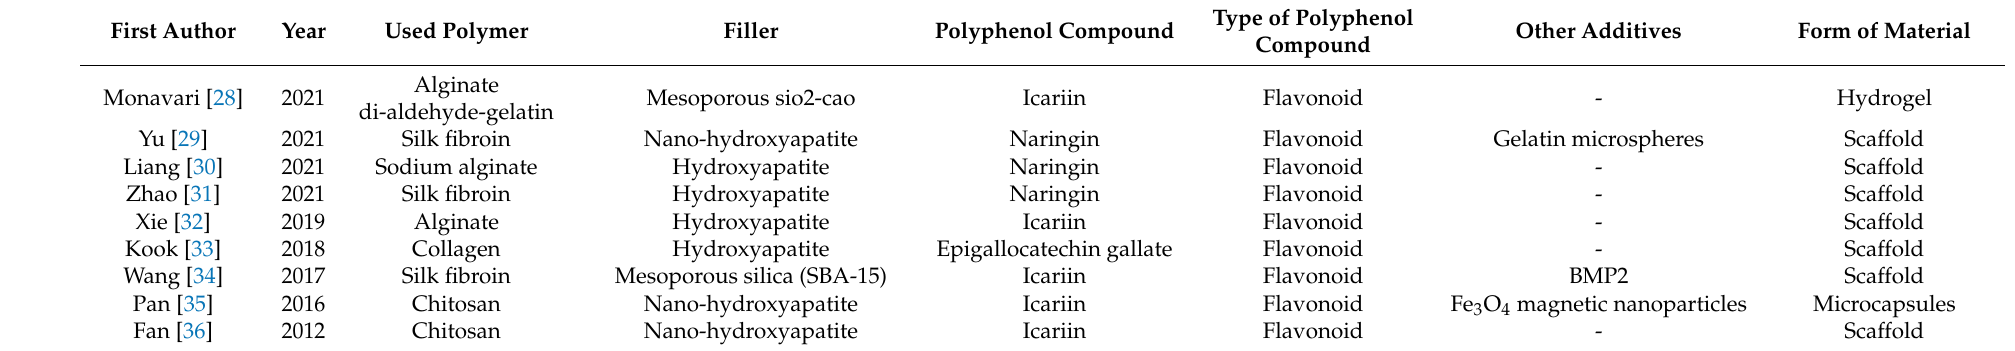
Table 2. List of reports on composites based on natural polymers.